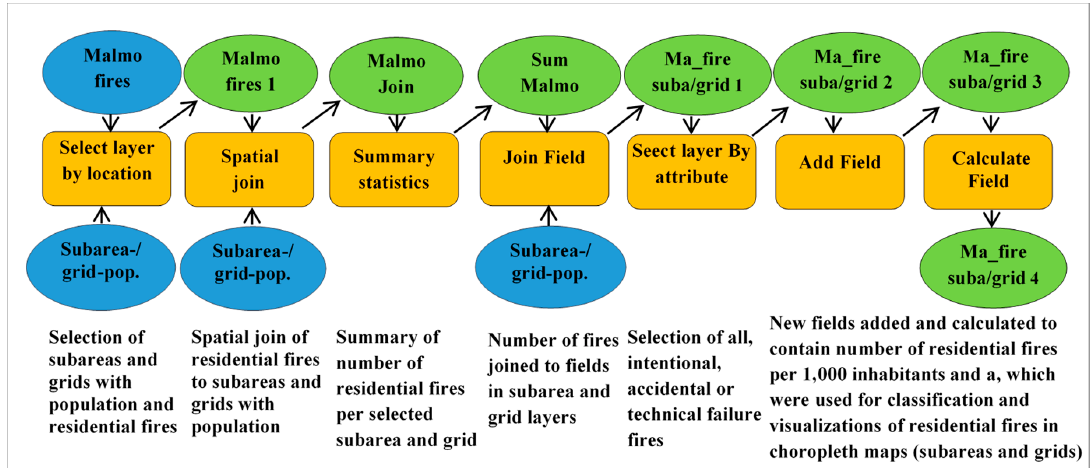
Figure 6. Modeling of the spatial join of fire data to subareas and grids and normalization with 196 population data. The model is developed with the model builder tool in ArcGIS desktop. 197